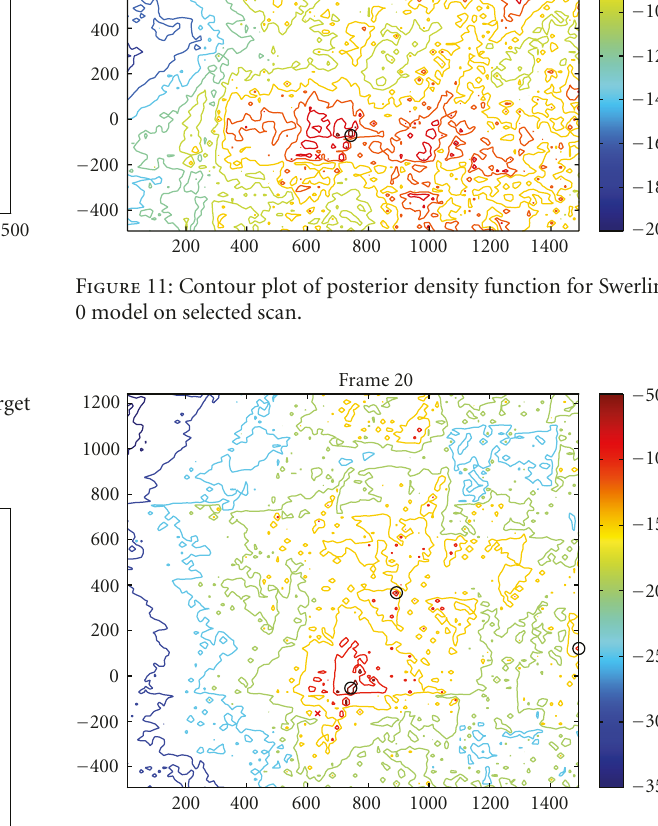
Figure 12: Contour plot of posterior density function for Swerling 1 model on selected